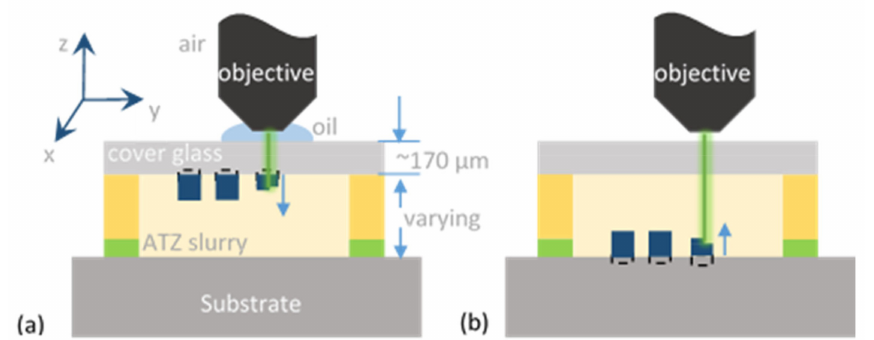
Figure 1. Schematics of the fabrication setups. The material is exposed to the laser light in both setups from the top. ( a ) Head-first fabrication is used for highest resolution and ( b ) structure fabrication at the bottom of the substrate through several hundred microns of ATZ